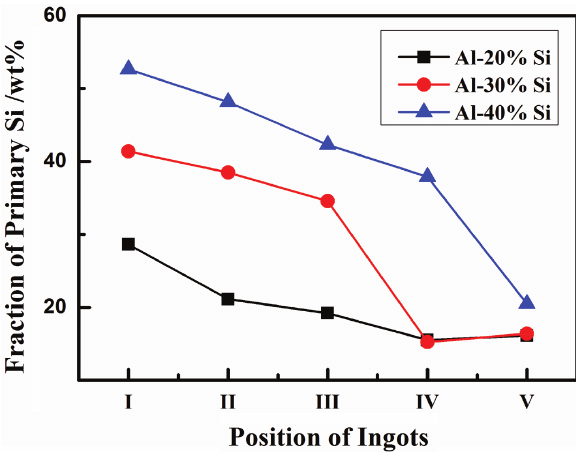
Figure 5: Mass fraction of primary silicon flakes in different parts of ingots.